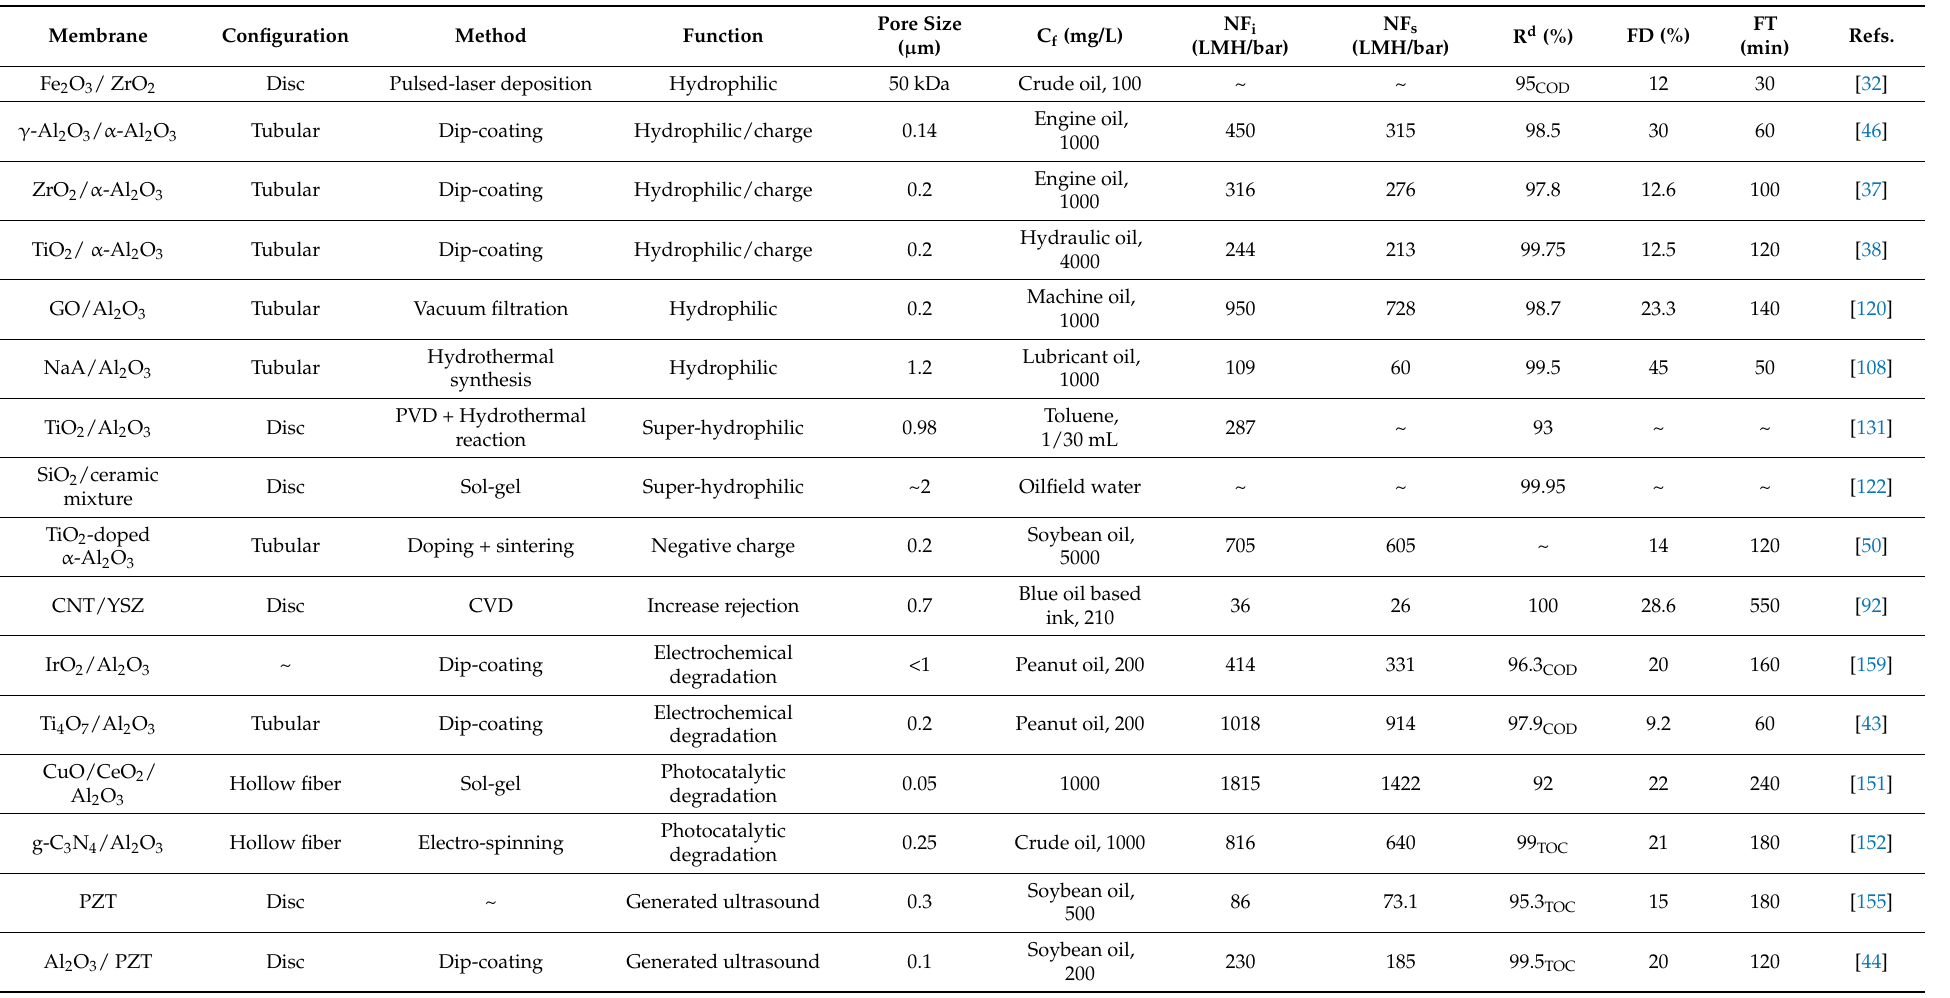
Table 3. Comparison of the performance of antifouling ceramic membranes for oily wastewater